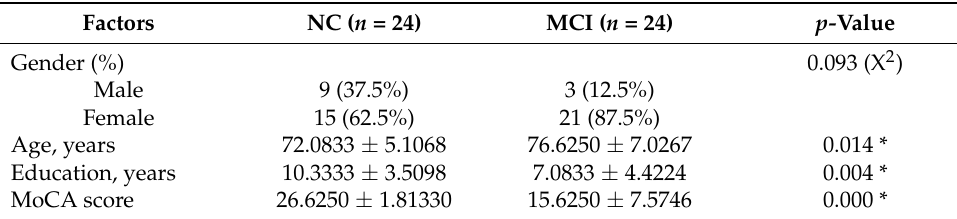
Table 2. Demographic and Characteristics of the NC and MCI subject groups.